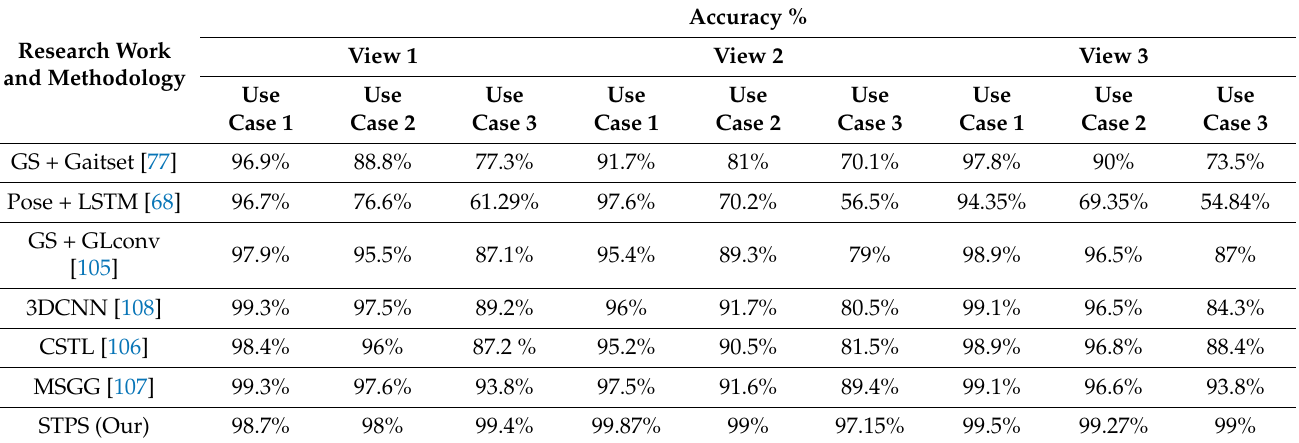
Figure 7. STPS Gait Recognition Results for Use Cases 1, 2, 3, and 4 and Views 1, 2, and 3. Table 2. Comparison of the Presented Work with Existing Work under All Three Views and Use